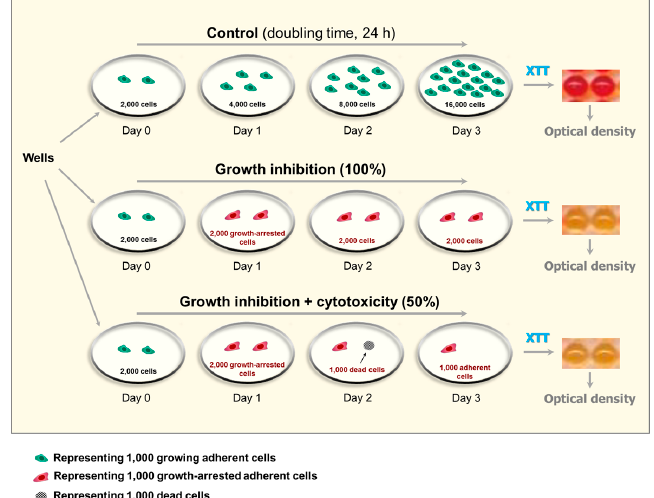
Figure 3. Depiction of anticipated outcome of multiwell plate colorimetric (XTT) assays after treatments that result in cytostatic (growth inhibition) effect only (e.g., 5 Gy of ionizing radiation), or cytostatic plus cytotoxic effects (e.g., >40 μ M cisplatin). The example is given for a culture with a control population doubling time of 24 h. In this case, for “control” wells (upper left well), seeding 2000 cells per well (day 0) and incubating them with growth medium for 3 days (upper right well) will result in 16,000 cells/well at the time of optical density measurement. For “radiation” wells (middle left well) and “cisplatin” wells (lower left well), the number of cells per well is expected not to increase from day 0 to day 3, due to induction of growth arrest in virtually all cells (irradiation) or induction of growth arrest plus loss of viability (cisplatin treatment). It is important to note that most solid tumor-derived cell lines (e.g., HCT116) have shorter population doubling times than 24 h [22]. In a typical assay, the cells are plated at “optimal” densities in the wells of a microtiter plate, exposed to a genotoxic agent, and incubated for 3 days. XTT (or MTT) is added to each well, and cultures are incubated for a few hours to allow the viable cells to covert the yellow tetrazolium salt (XTT or MTT) to its colored formazan derivative; XTT formazan is orange in color whereas MTT formazan is purple. The number of cells inoculated per well and the duration of cell incubation with XTT or MTT need to be optimized for each cell line.